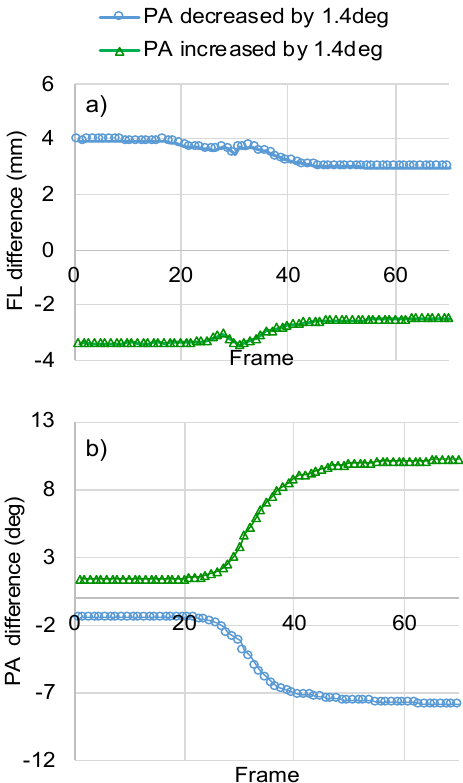
Figure 9. The sensitivity of FL and PA to small changes in the initialized PA. Different initialization scenarios are generated by rotating the reference initialization line to the left (1.4 deg reduction in initial PA) or to the right (1.4 deg increase in initial PA). The resulting difference in FL ( a ) and PA ( b ) relative to the reference initialization is presented for all frames of a contraction video (Figure 7a,c).